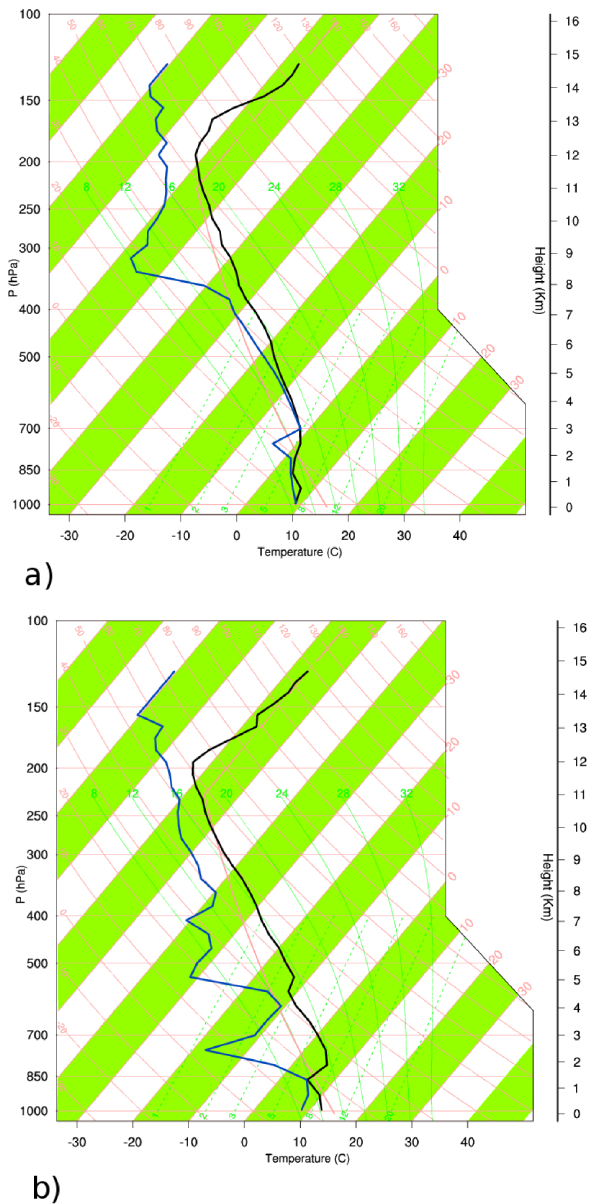
Fig. 5. Skew-T profiles from Herstmonceux station at (a) 00:00UTC, 2 June 2006 and (b) 00:00UTC, 3 June 2006.